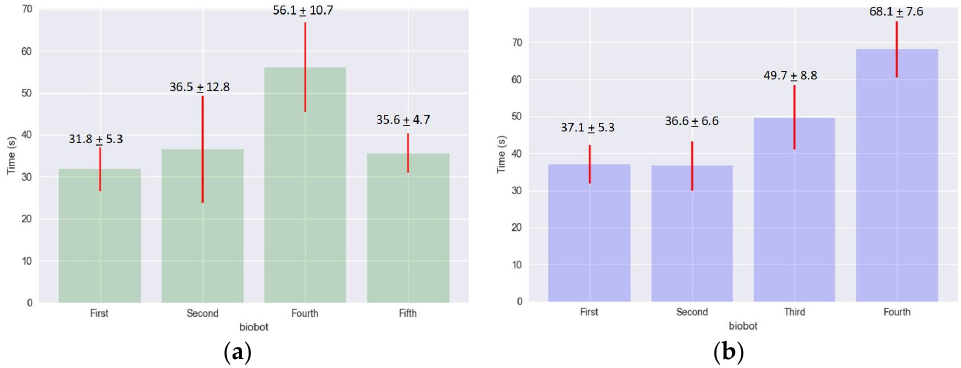
Figure 17. Required time for path following mission: ( a ) no obstacle, ( b ) with obstacle.